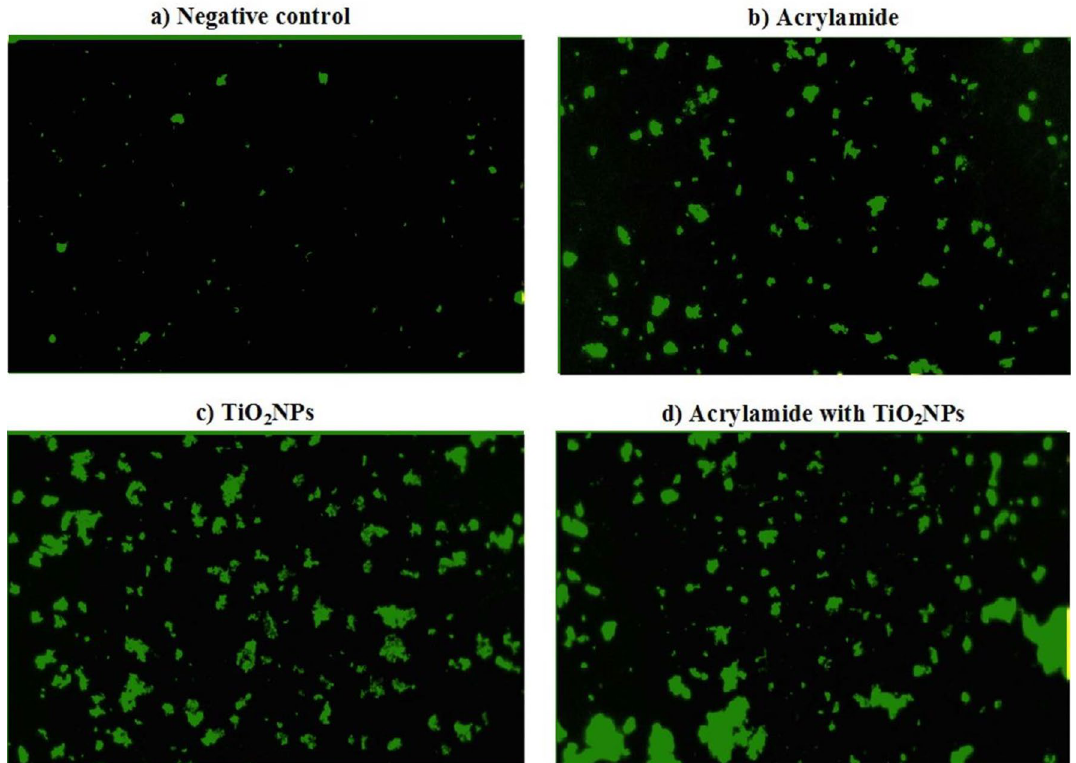
Figure 5. Level of intracellular ROS generation in the brain tissues of ( a ) negative control group, ( b ) acrylamide administered group, ( c ) TiO 2 NPs administered group and ( d ) group administered acrylamide with TiO 2